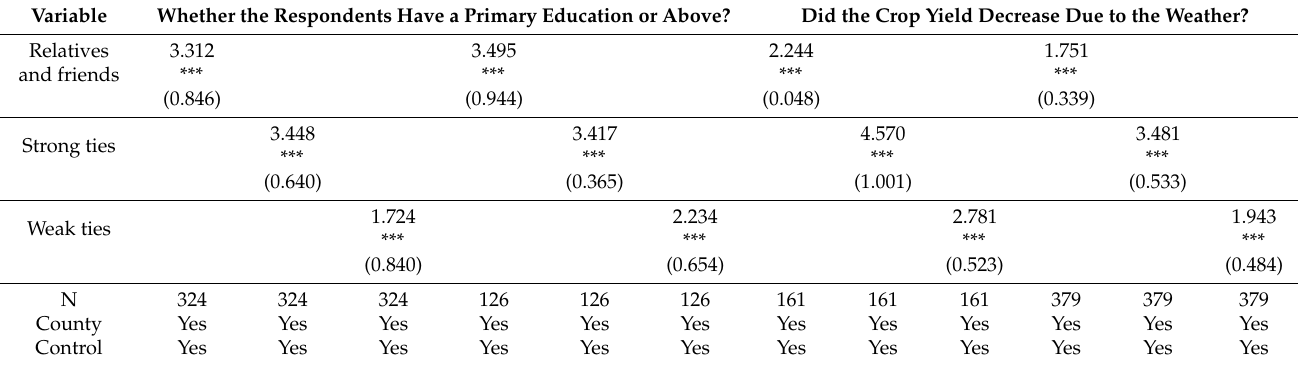
Table 5. Heterogeneity